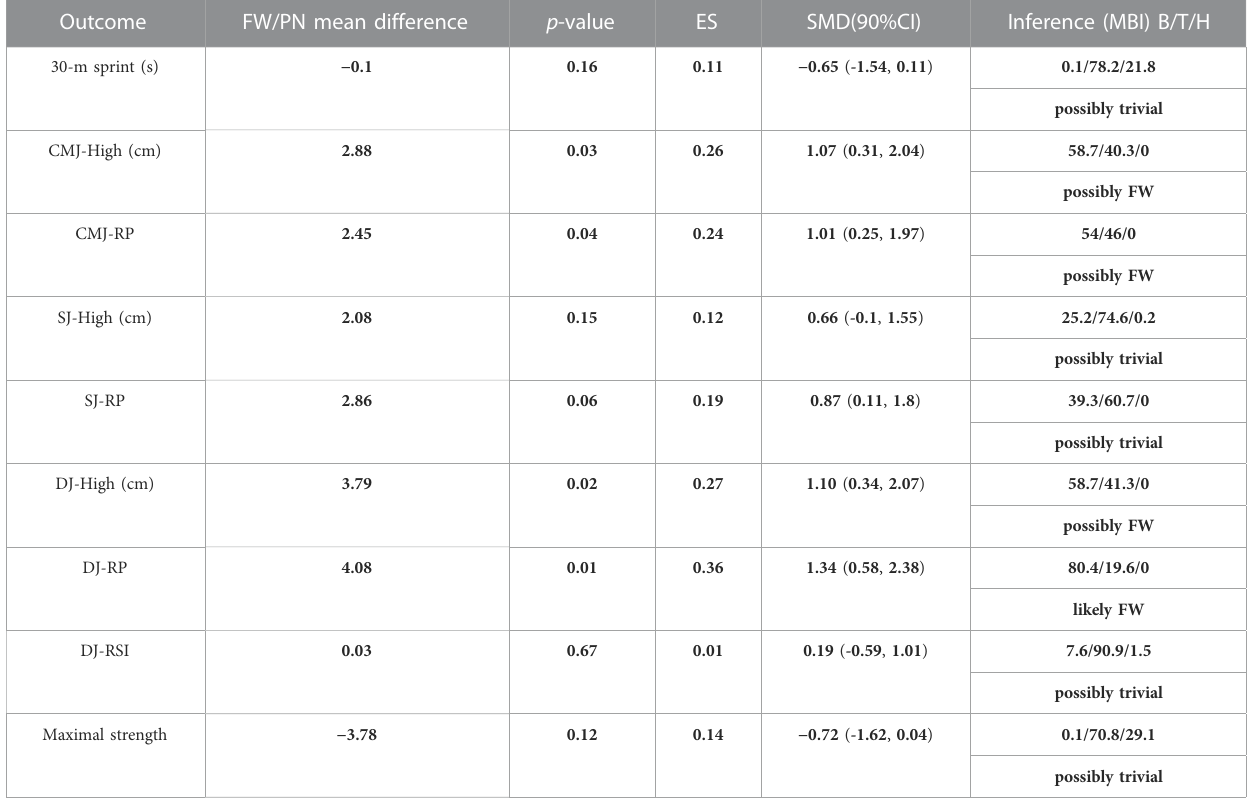
Comparisonofdifferencesbetweenthegroups.Dataareexpressedasthemean±standarddeviations.ES=effectsize(Cohen ’ s);CI=con fi denceinterval;SMD=standardizedmeandifference; MBI= margin-basedinference. FW/PN = group comparisonof groupdifferencesbetween the freeweight and pneumatic resistance groups. *Signi fi cant differences( p < 0.05) before and after training;T-30=30-mshortstroketime;CMJ-high=heightofreverseverticaljump;CMJ-RP=relativepowerofreverseverticaljump;SJ-high=heightofisometricsquatjump;SJ-RP=relative powerofisometricsquatjump;DJ-high=heightofdropjump;DJ-RP= relativepowerofdropjump;DJ-RSI=reactivepowerindexofthefallingjump;andFW/PN= intergroupcomparison between the free weight and the pneumatic resistance groups.